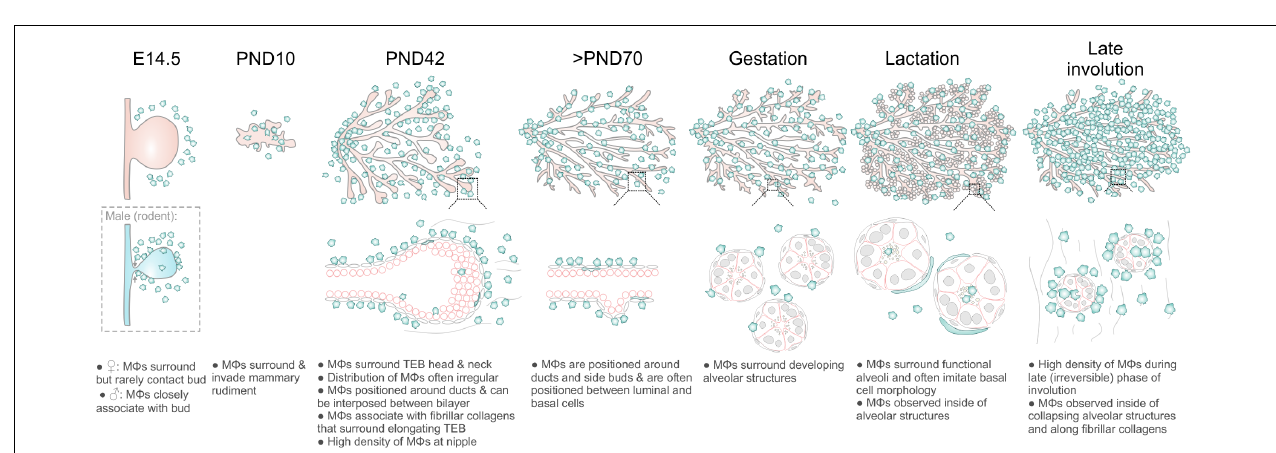
FIGURE 5 | M φ s in the mammary glands of mice during post-lactational involution. (A–C) Maximum intensity z -projection and single optical ( z ) slices of cleared mammary tissue from Csf1r-EGFP mice during involution (96 h post forced weaning). K8 immunostaining shows luminal cells; SMA immunostaining reveals basal cells and SMA-positive vessels. Arrowheads in (B) show a cluster of GFP + M φ s inside of collapsed alveolar units. (C) SHG showing fibrillar collagens surrounding regressing alveoli. Images are representative of 3 mice.